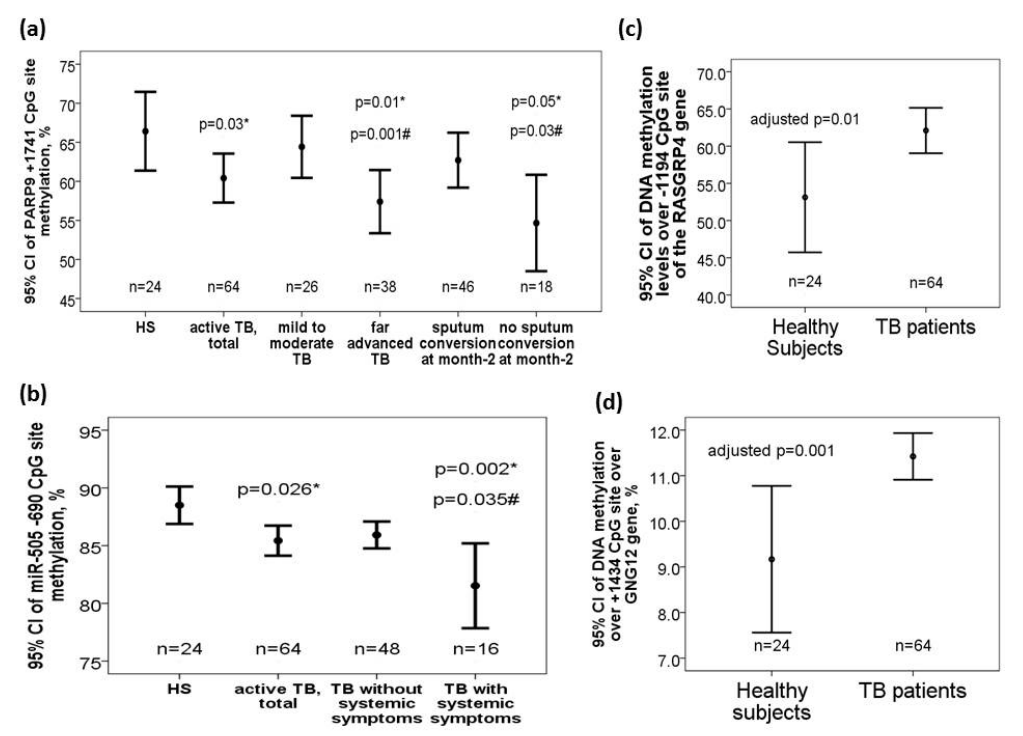
Figure 2. Differential DNA methylation levels over the PARP9 , miR-505 , RASGRP4 , and GNG12 genes in the validation cohort. ( a ) PARP9 (+1741 CpG site) gene was hypomethylated in TB patients and further hypomethylated in those with far advanced lesions on CXR or without sputum smear/culture conversion to negative after 2-month anti-TB treatment. ( b ) miR-505 ( − 690 CpG site) gene was hypomethylated in TB patients, and further hypomethylated in those with systemic symptoms. ( c ) RASGRP4 ( − 1194 CpG site) and ( d ) GNG12 (+1434 CpG site) genes were both hypermethylated in TB patients versus HS. *compared with HS and adjusted by multivariate linear regression analysis . #compared with TB patients without specific clinical phenotype and adjusted by multivariate linear regression analysis.